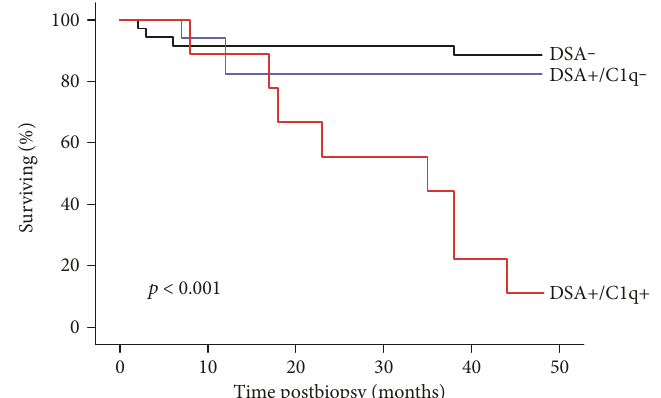
Figure 2: Postbiopsy kidney graft survival in pediatric patients strati fi ed according to the donor-speci fi c HLA antibody- (DSA-) C1q status at the time of indication biopsy. Patients with C1q-DSA positivity had a signi fi cantly inferior graft survival compared to patients without DSA ( p < 0 001 ). Patients with DSA but without C1q positivity showed comparable graft survival to DSA-negative patients ( p = 0 55 ) but signi fi cantly better graft survival than patients with C1q-DSA positivity ( p = 0 001 ). Modi fi ed from